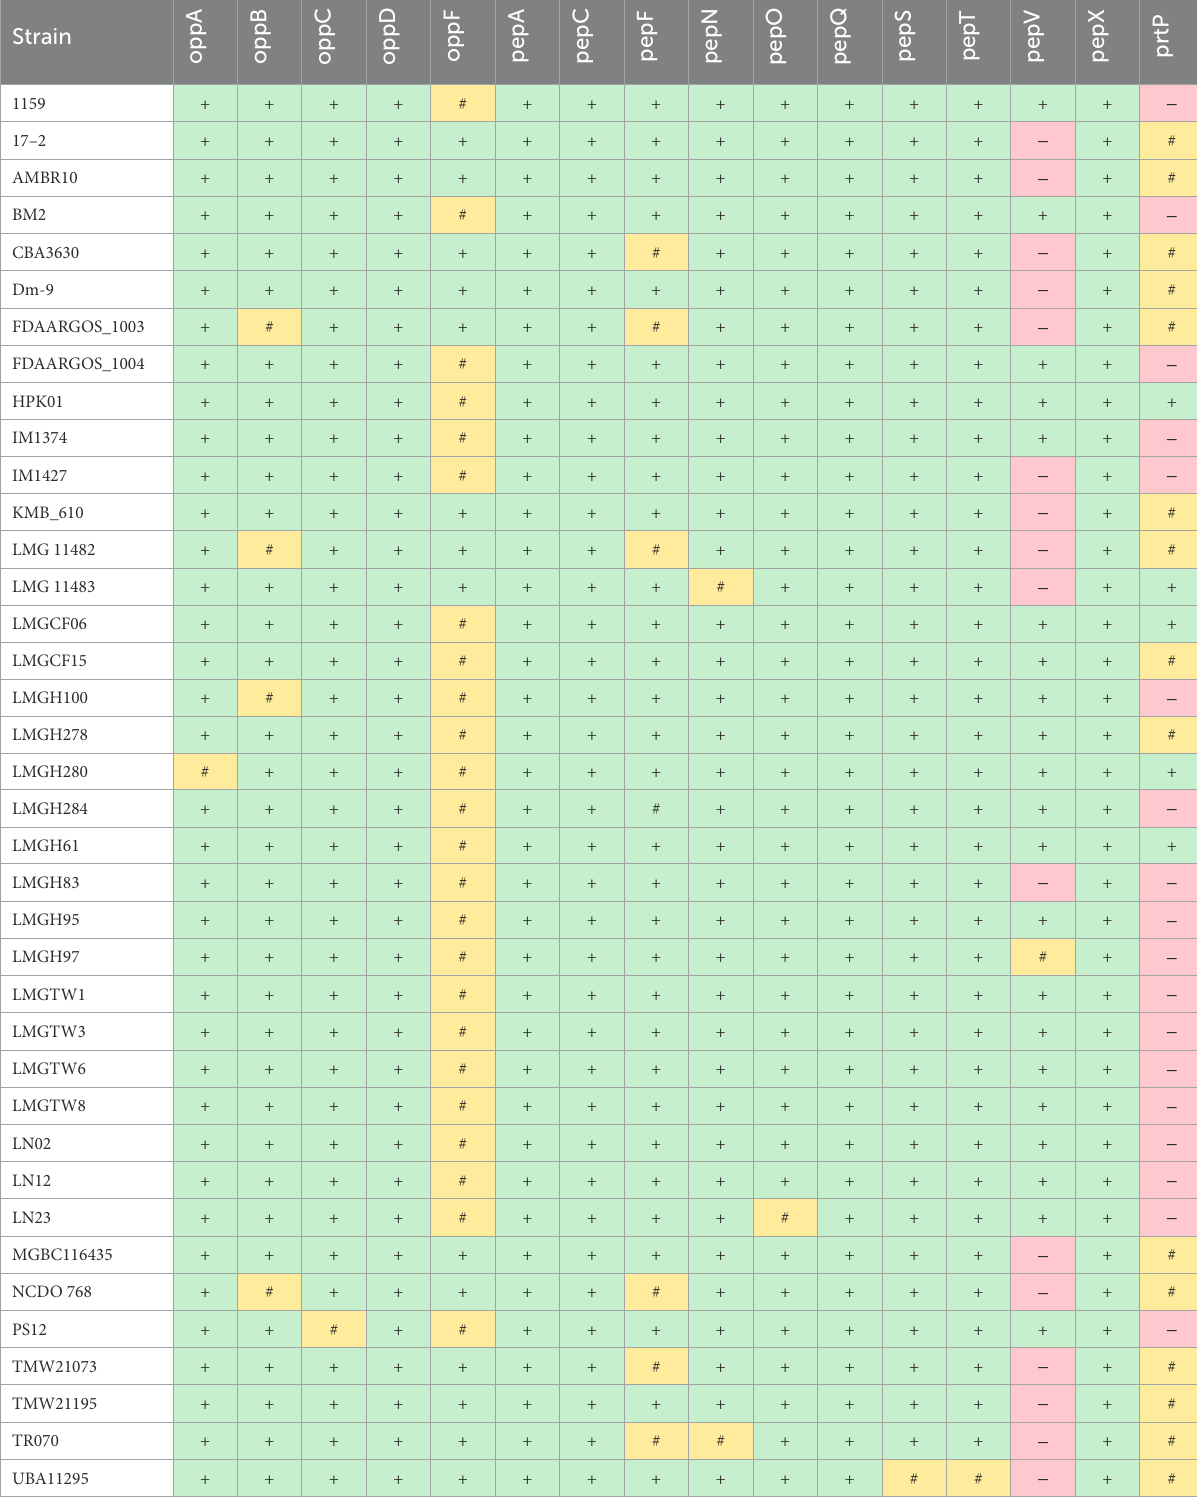
TABLE 3 Presence (+) and absence ( − ) of putative proteolytic activity of 38 Ln. pseudomesenteroides .